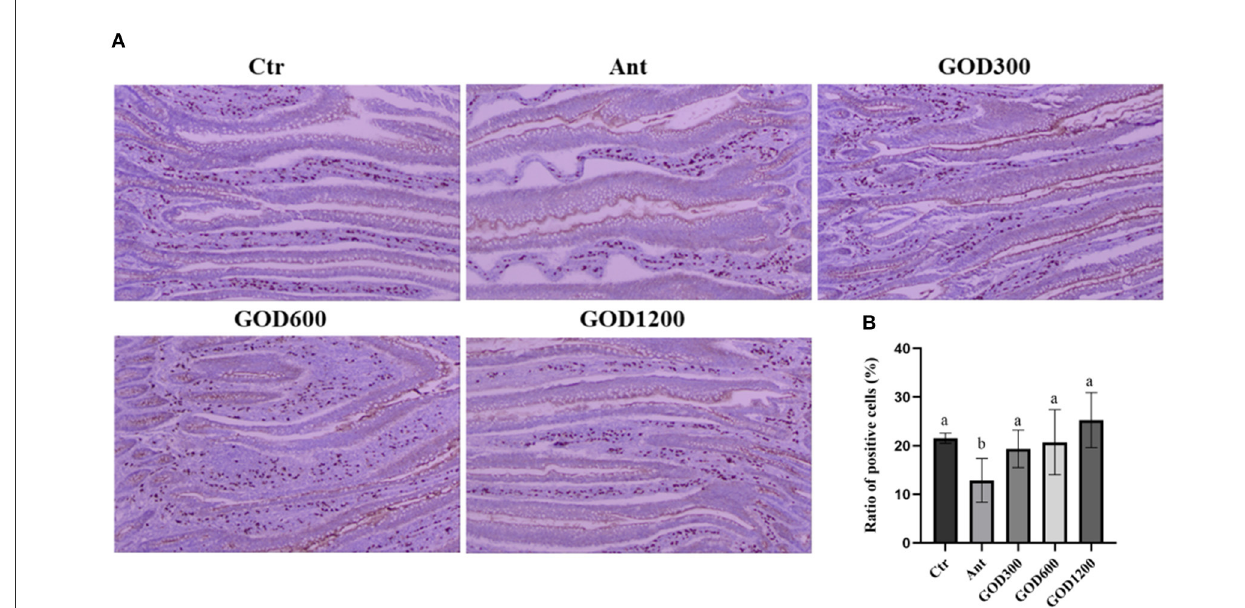
FIGURE1 The effect of GOD-supplemented dietary on SIgA distribution in the jejunum of broilers on day 42 was examined by immunohistochemistry. SIgA-positive cells were stained prominently brown. The pictures were observed at 100 × magnification ( n = 6) (A) . The ratio of positive cells was calculated and analyzed among the five treatment groups (B) ( P < 0.05). Ctr, negative control fed with the basal diets; Ant, positive control fed with the basal diets added 50 mg/kg aureomycin; GOD300, GOD600, and GOD1200, the basal diets supplied with 300, 600, and 1,200 U/kg glucose oxidase, respectively. a,b Means within a row with no common superscripts are significantly different ( P < 0.05). Ctr, negative control group fed with the basal diets; Ant, positive control group fed with the basal diets added 50 mg/kg aureomycin.